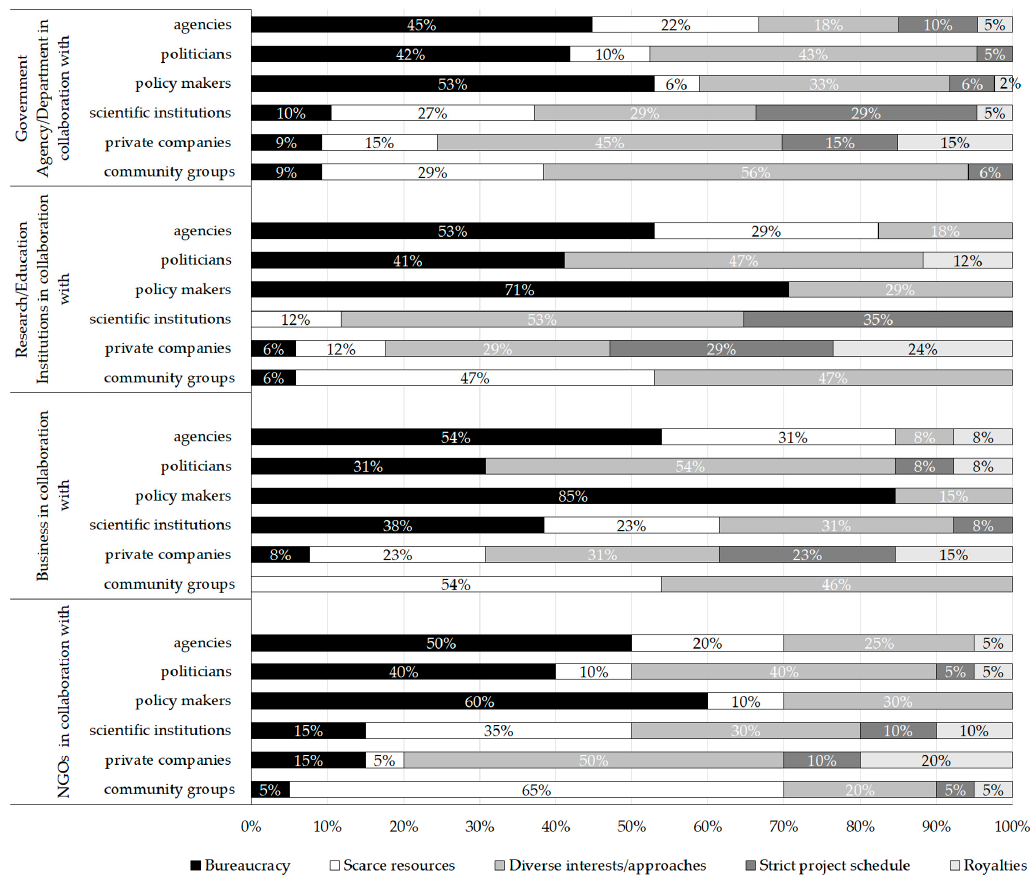
Figure 7. Perceived shortcomings from collaborations with other categories. Percentages of selection of the suggested shortcoming given by each category of respondent ( n = 137).